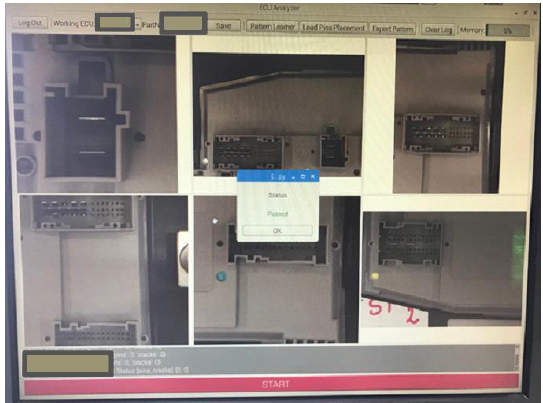
Figure 23. An overview of the user interface and a test result for no detected faults. A few of the parameters are presented in Figure 24.